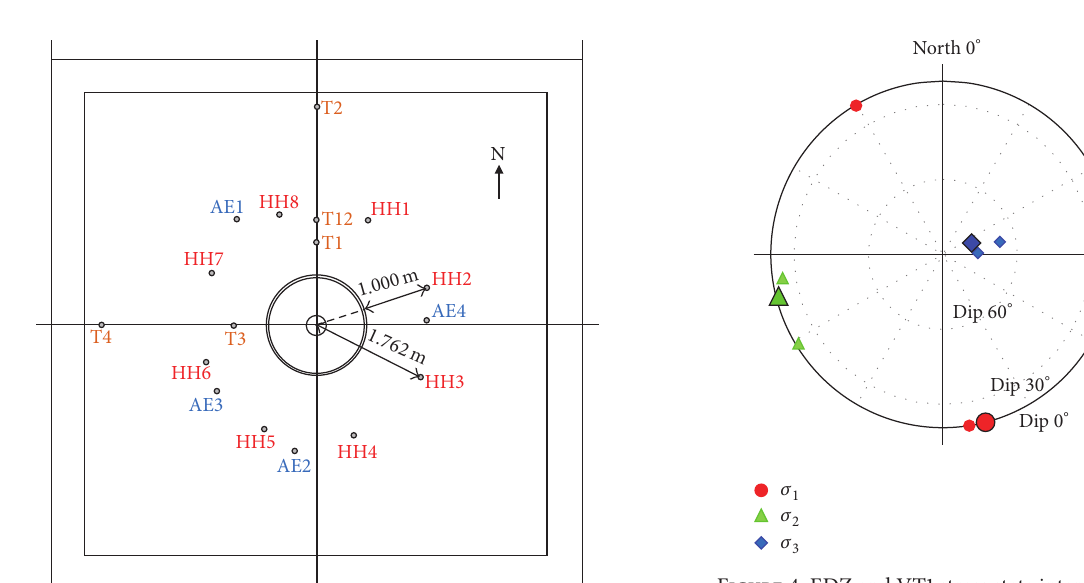
Figure 4: EDZ and VT1 stress state interpretation